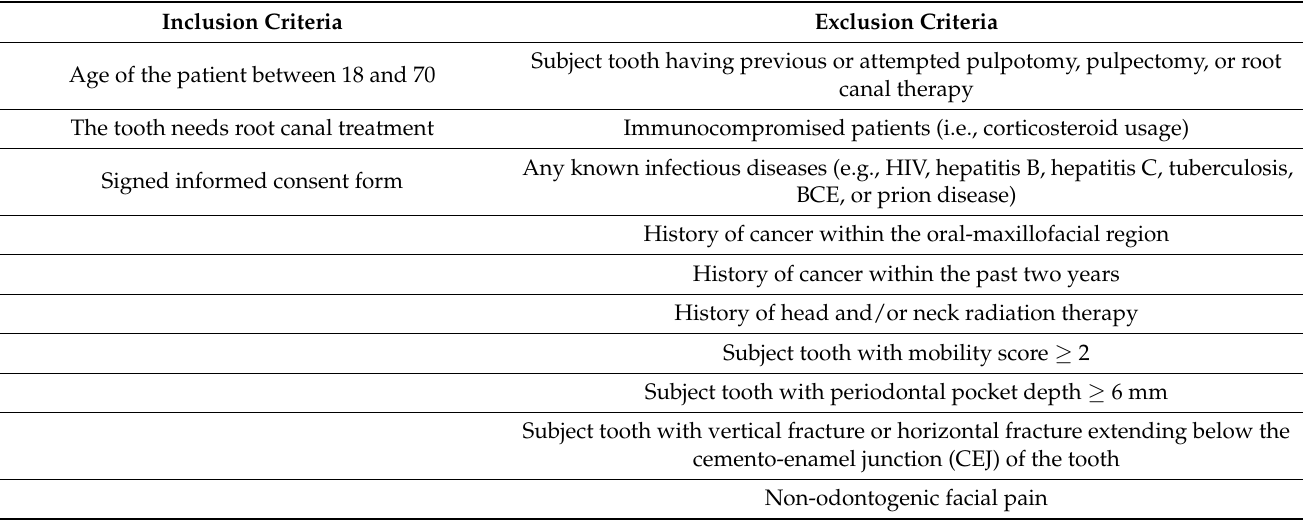
Table 1. Inclusion and exclusion